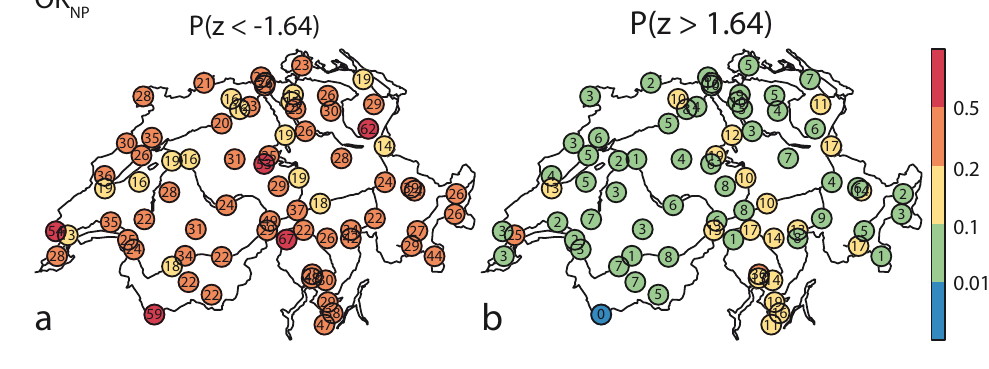
Fig. 13. Square root of the Kriging variance for the test case 1 and OK and KED method variants (mm).